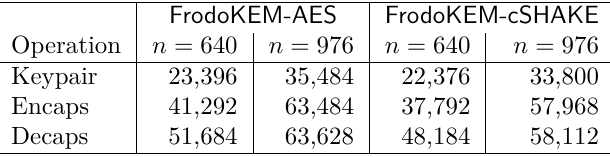
Table 6: Stack usage in bytes for our microcontroller implementation.